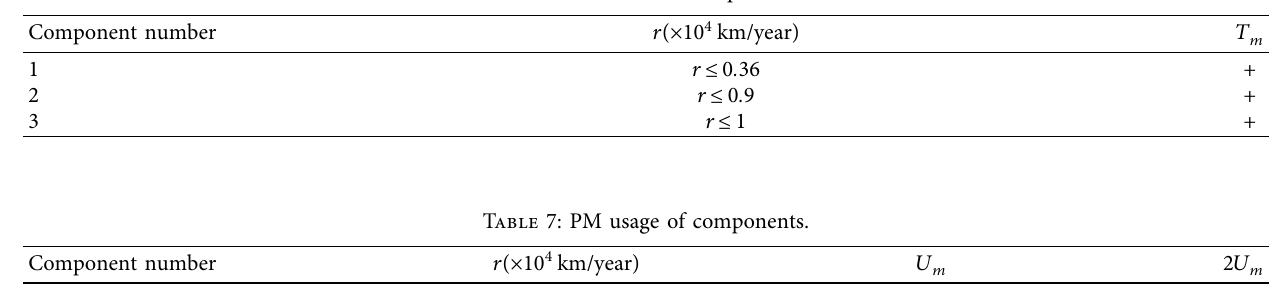
Table 6: PM time of components.